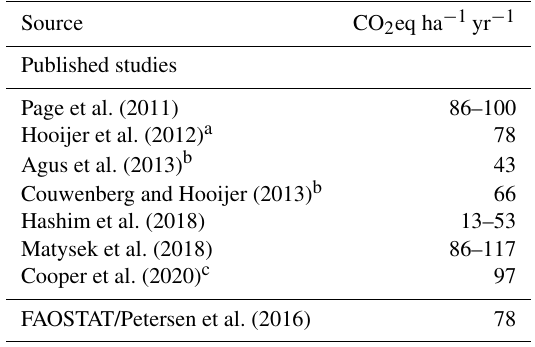
Table 8. Comparison of EFs for oil palm plantations on organic soils from peer-reviewed literature and combined FAOSTAT and Petersen et al. (2016) spatial